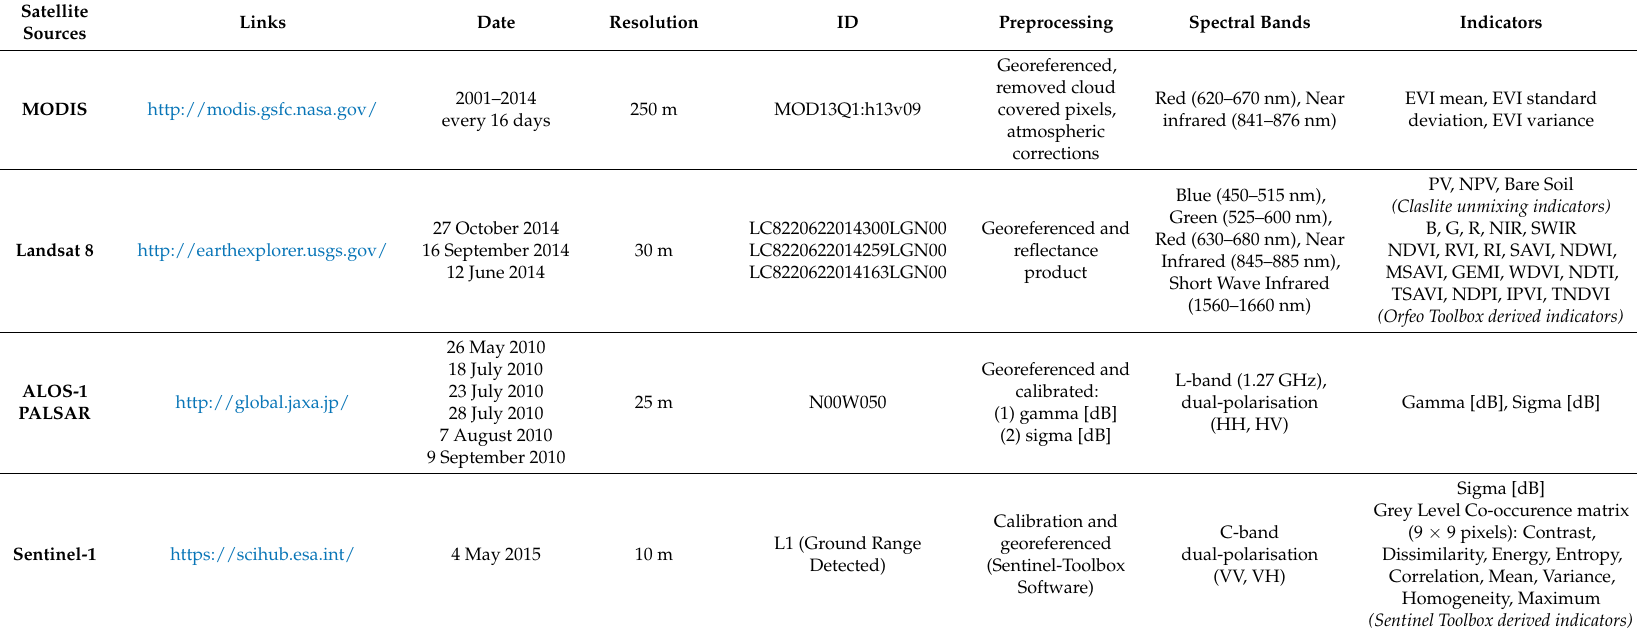
Table A1. Remote sensing metadata and derived